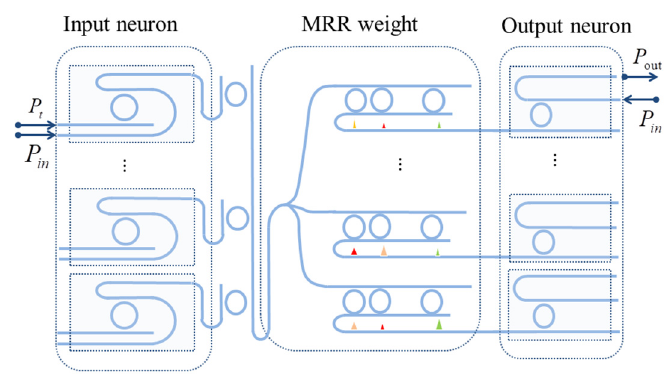
Figure 1. The architecture of all ‐ MRR ‐ based photonic SNN.